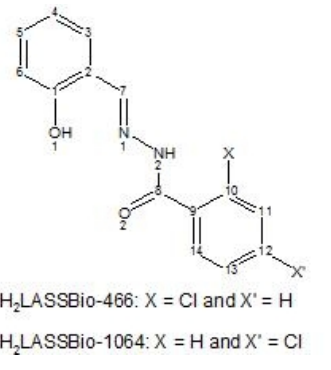
Figure 1. Generic structure of salicylaldehyde 2-chlorobenzoyl hydrazone (H